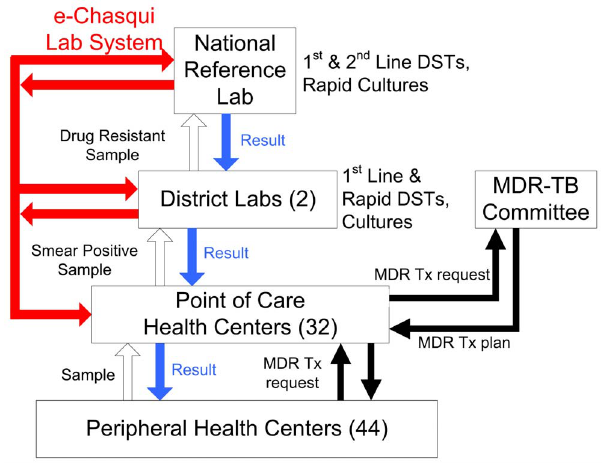
Figure 1. Flow of samples, results, and MDR treatment requests and plans within the Peruvian National TB Program. TB microscopy is carried out at point of care health centers, and smear positive samples are only referred for DST if there are risk factors for MDR TB.